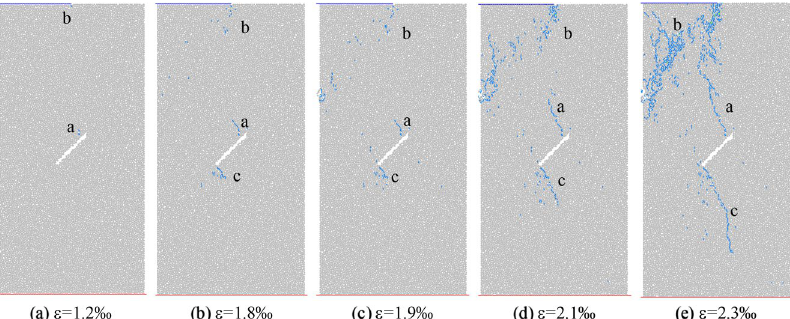
Figure 15. Failure process of specimen under uniaxial compression under eccentric load.